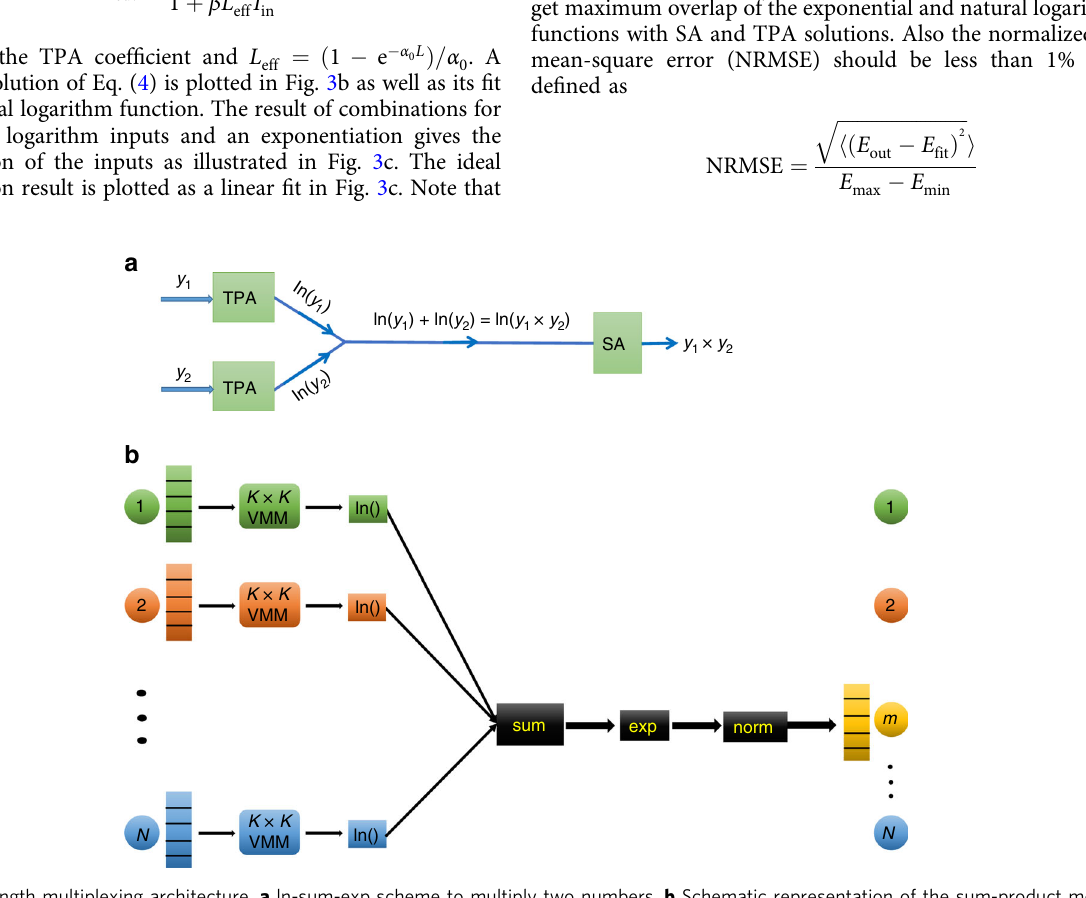
Fig. 2 Wavelength multiplexing architecture. a ln-sum-exp scheme to multiply two numbers. b Schematic representation of the sum-product message passing algorithm (SPMPA) for node m . The spectral bandwidth is divided equally as a representation of each node (different color indicates different wavelength). The summation unit sums across wavelength for each probability vector that emerges from the natural logarithm (ln)